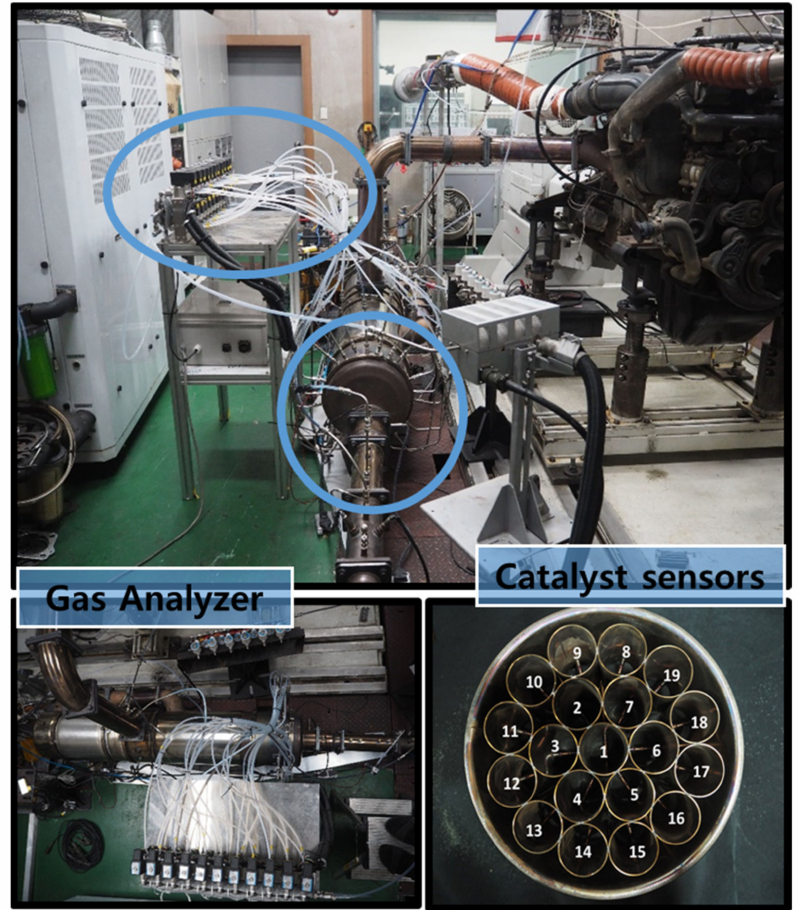
Figure 7. Sampled ammonia values in the catalyst